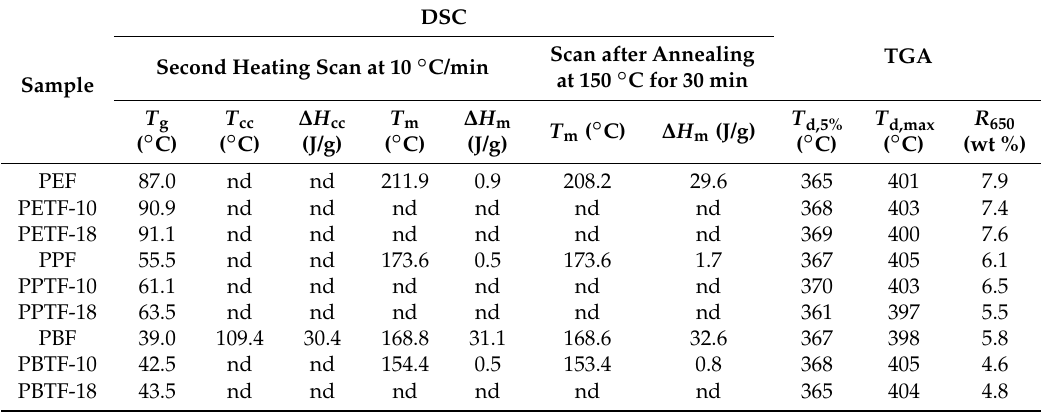
Table 2. Thermal properties of PEF, PPF, PBF, and the copolyesters.